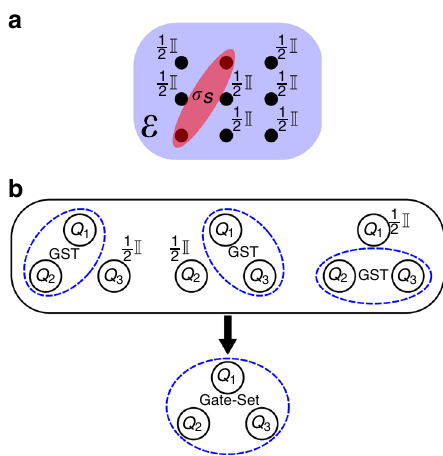
Fig. 1 Schematic of the pairwise perturbative ansatz. a Pairwise perturbative ansatz (PAPA) tomography: for all qubit pairs, characterize the effective two-qubit process (Choi state σ ) when the unknown N -qubit S process E occurs, and all other qubits start in the maximally mixed state. b Three-qubit PAPA + GST: characterized two-qubit gate sets are bootstrapped to a three-qubit gate set via